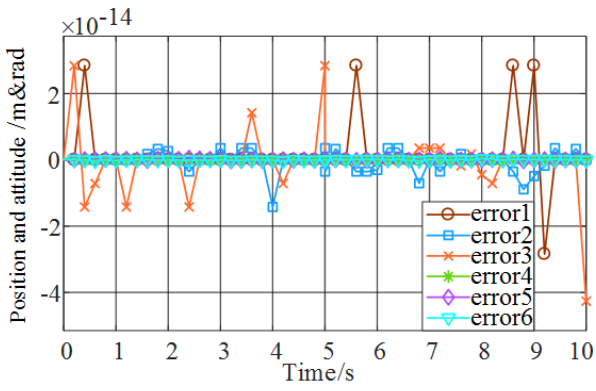
Figure 4. End position